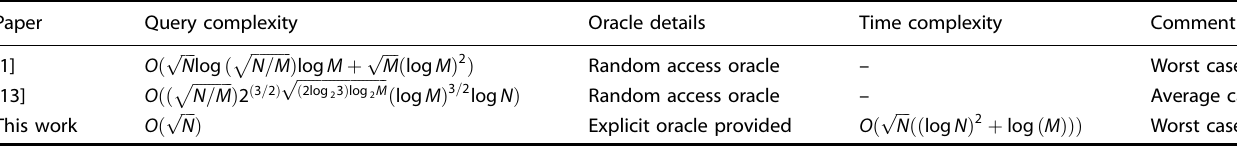
Table 1. Comparison of our work with prior algorithms discussed in this